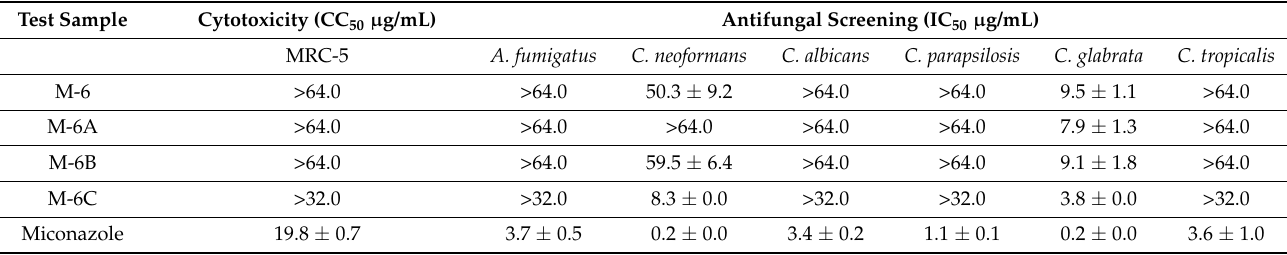
Table 5. In vitro antifungal and cytotoxic activity of subfraction M-6 and the binary mixtures M-6A, M-6B, and M-6C from C. cowellii